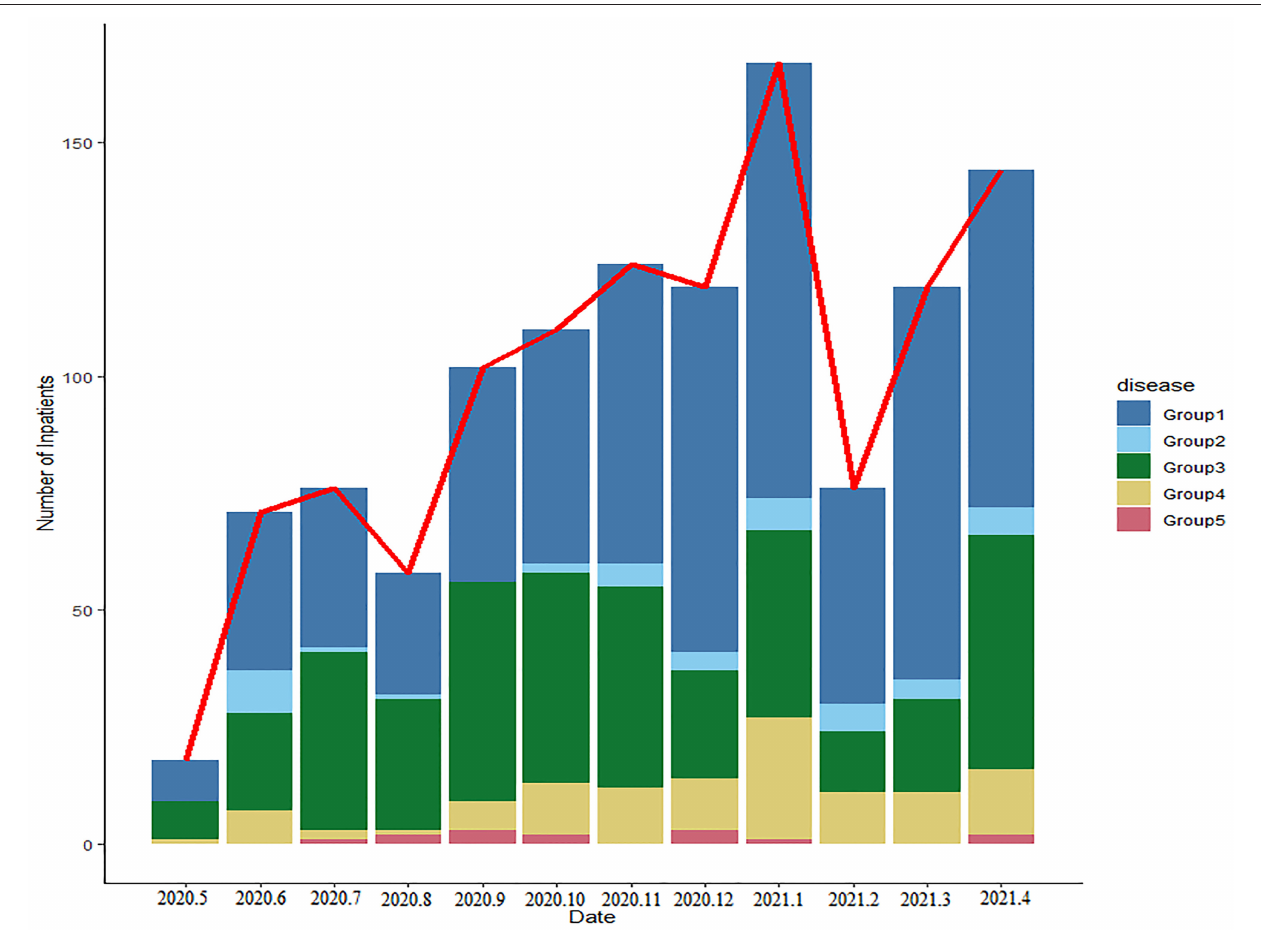
FIGURE 4 | The changes in the number and proportions of children with lower respiratory tract infections (LRTIs) per month in this